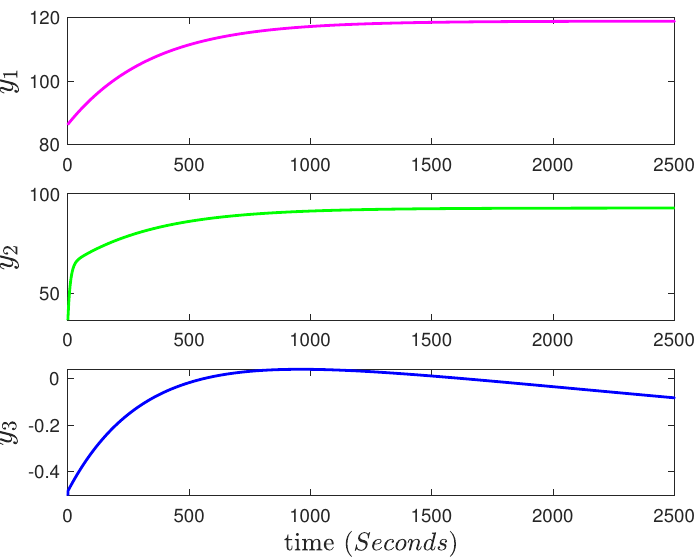
Figure 2. Step-response of the non-linear system (1) at 50% operation condition.